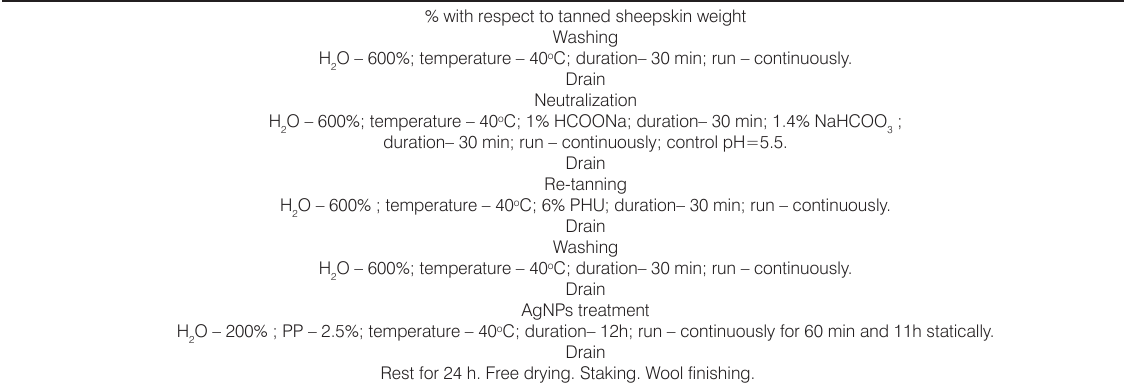
Table 2. Parameters of medical sheepskins technology using silver nanoparticle-based